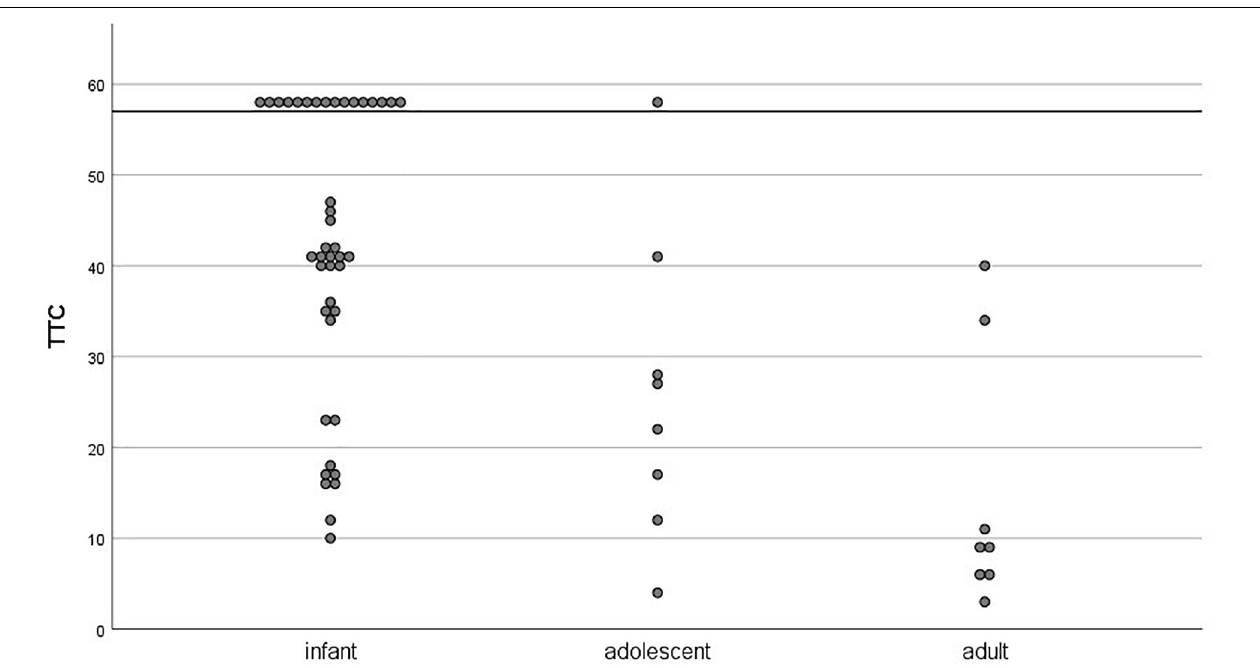
FIGURE 6 | Individual trials-to-criterion (three CRs out of a block of 6 paired trials) for the acquisition session as a function of age group. Participants who did not reach criterion during the acquisition session (48 paired trials) were assigned a score of 58 and are visible above the horizontal